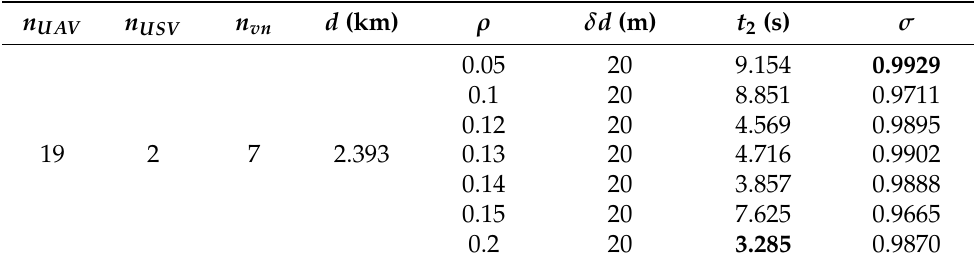
Table 10. Algorithm results: execution time (after time execution improvement) and performance indicator σ ( nt = 3, LB = 92 dB, d = 2.393 km).